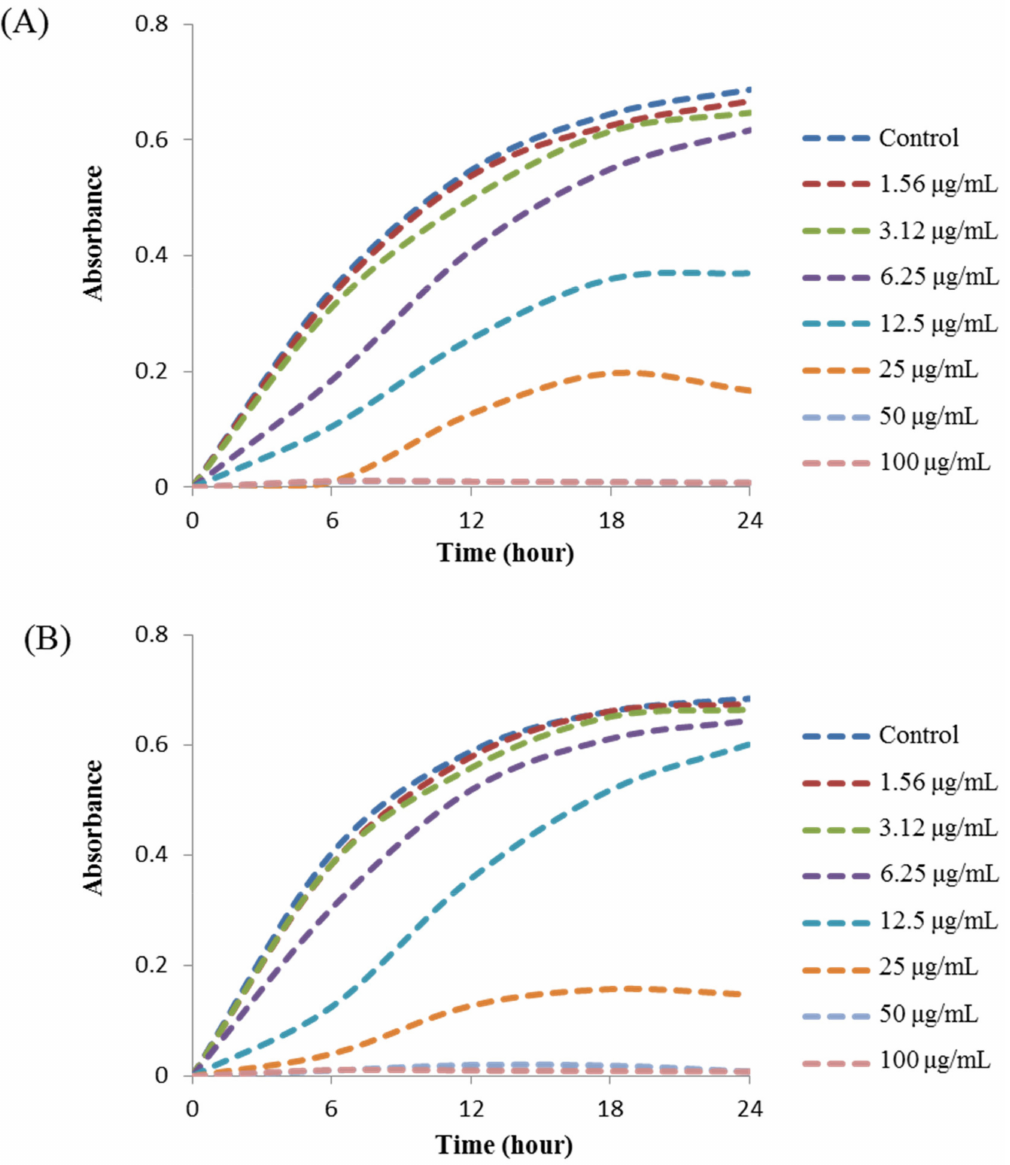
Figure 7. Growth curves of K. pneumoniae ( A ) and S. Enteritidis ( B ) cultured in MHB with different concentrations of Massilia sp. MAHUQ-52 mediated synthesized AgNPs to determine